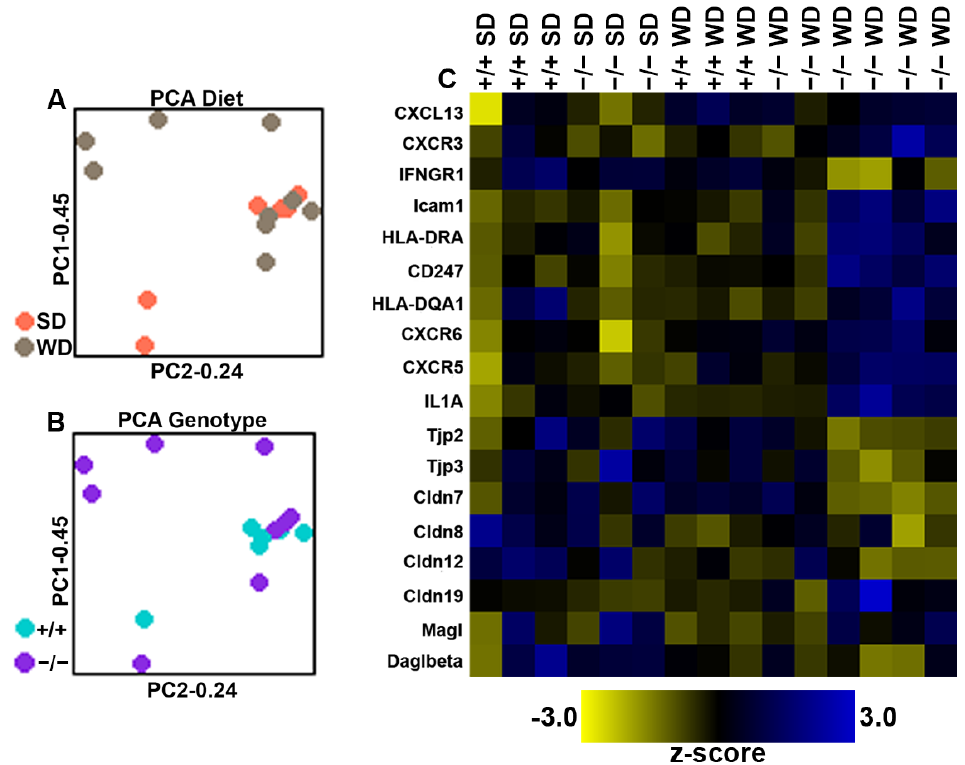
Figure 5. Principal Component Analysis (PCA) of expression of genes in the large-intestinal epithe- lium. PCA was performed across both diet ( A ) and genotype ( B ) to identify unique group clustering within the 100 probed genes in the custom NanoString panel. A representative heatmap of all differentially expressed genes (DEGs) in the large intestine mucosa across either diet or genotype revealed increases in inflammatory transcripts and a downregulation in barrier-associated transcripts in intCB1R −/− mice fed WD ( C ). SD = standard diet, WD = western diet, +/+ = intCB1+/+ mice, −/− = intCB1−/− mice.